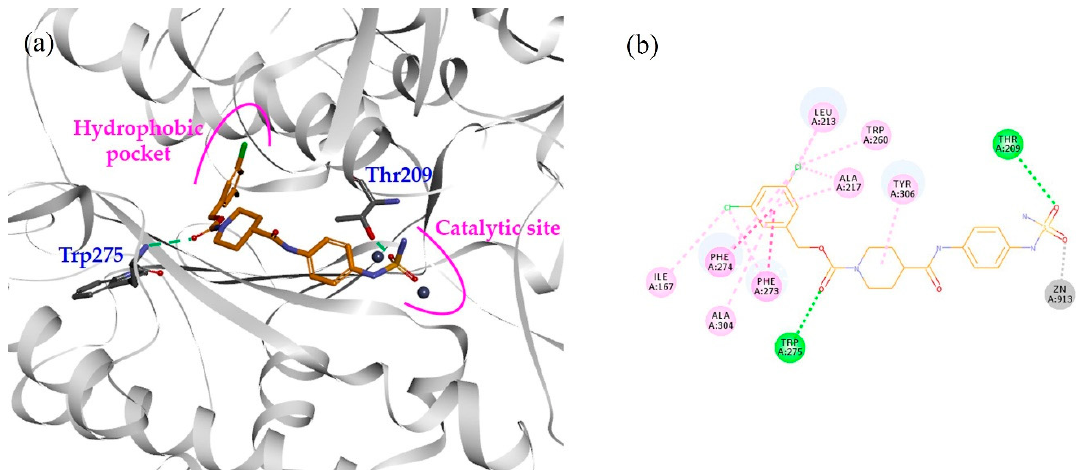
Figure 3. ( a ) Binding mode of compound 1 (orange stick model) inside the ATX binding pocket. It occupies the catalytic site as well as the hydrophobic pocket. ( b ) 2D interaction diagram of compound 1 ( orange line model). Hydrogen bonds and hydrophobic interactions with the active site residues are displayed as green and pink dashed lines, respectively. Electrostatic interaction with catalytic zinc ion is represented by gray dashed line. Table 1. Structures, activities, and predicted physicochemical properties of the compounds.